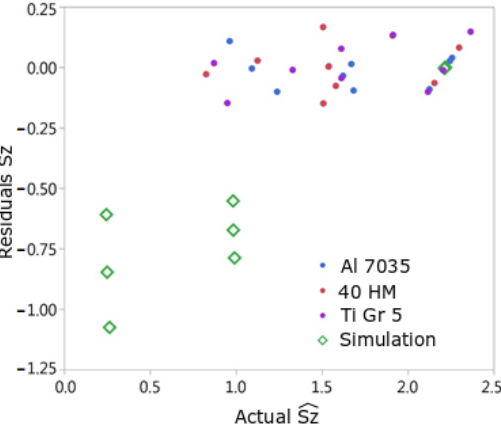
Figure 16. Graph of residuals depending on the real value of (cid:98) Sz for the tests used to build the model (Aluminum, Steel, Titanium) and the surface simulation tests after